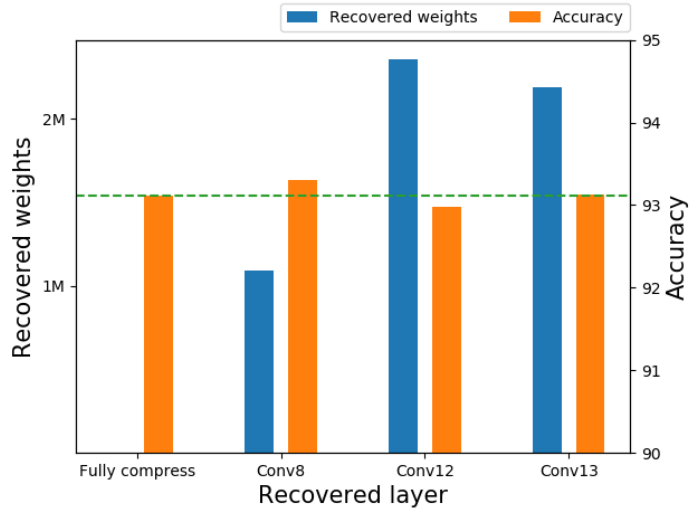
Figure 5. Comparison between the number of recovered weights and accuracy for selected layers.